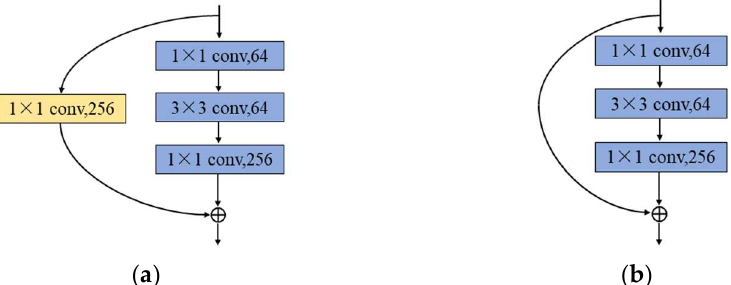
Figure 5. The network structure of the Conv Block and Identity Block in the Stage1 module. The 1 × 1 convolution kernel is a change in the dimension of the features. The structure of skip connection achieves the linear transfer of features. ( a ) The Conv Block network structure; ( b ) The Identity Block network structure.